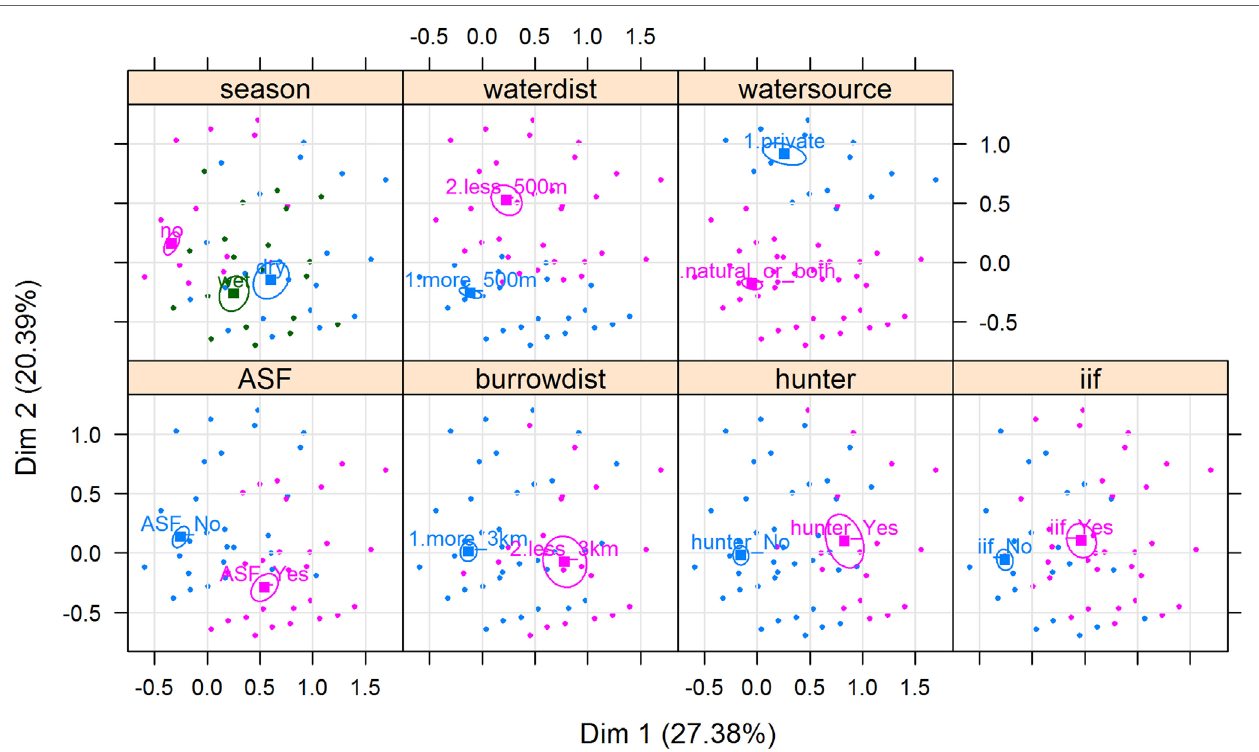
FigUre 5 | Biplot of individuals and variable categories with confidence ellipses . Labels for variable categories are displayed: watersource (private/natural_or_both); iif = indirect interaction (iif_Yes/iif_No); season = season of the ASF outbreak (dry/wet/no; “no” refers to no ASF outbreaks reported by the respondent); waterdist = HH distance from the pig’s water source (more_500 m/less_500 m); ASF = ASF outbreak (ASF_Yes/ASF_No); burrowdist = HH distance from a WH burrow (less than 3 km/more than 3 km); and hunter = respondent being a hunter